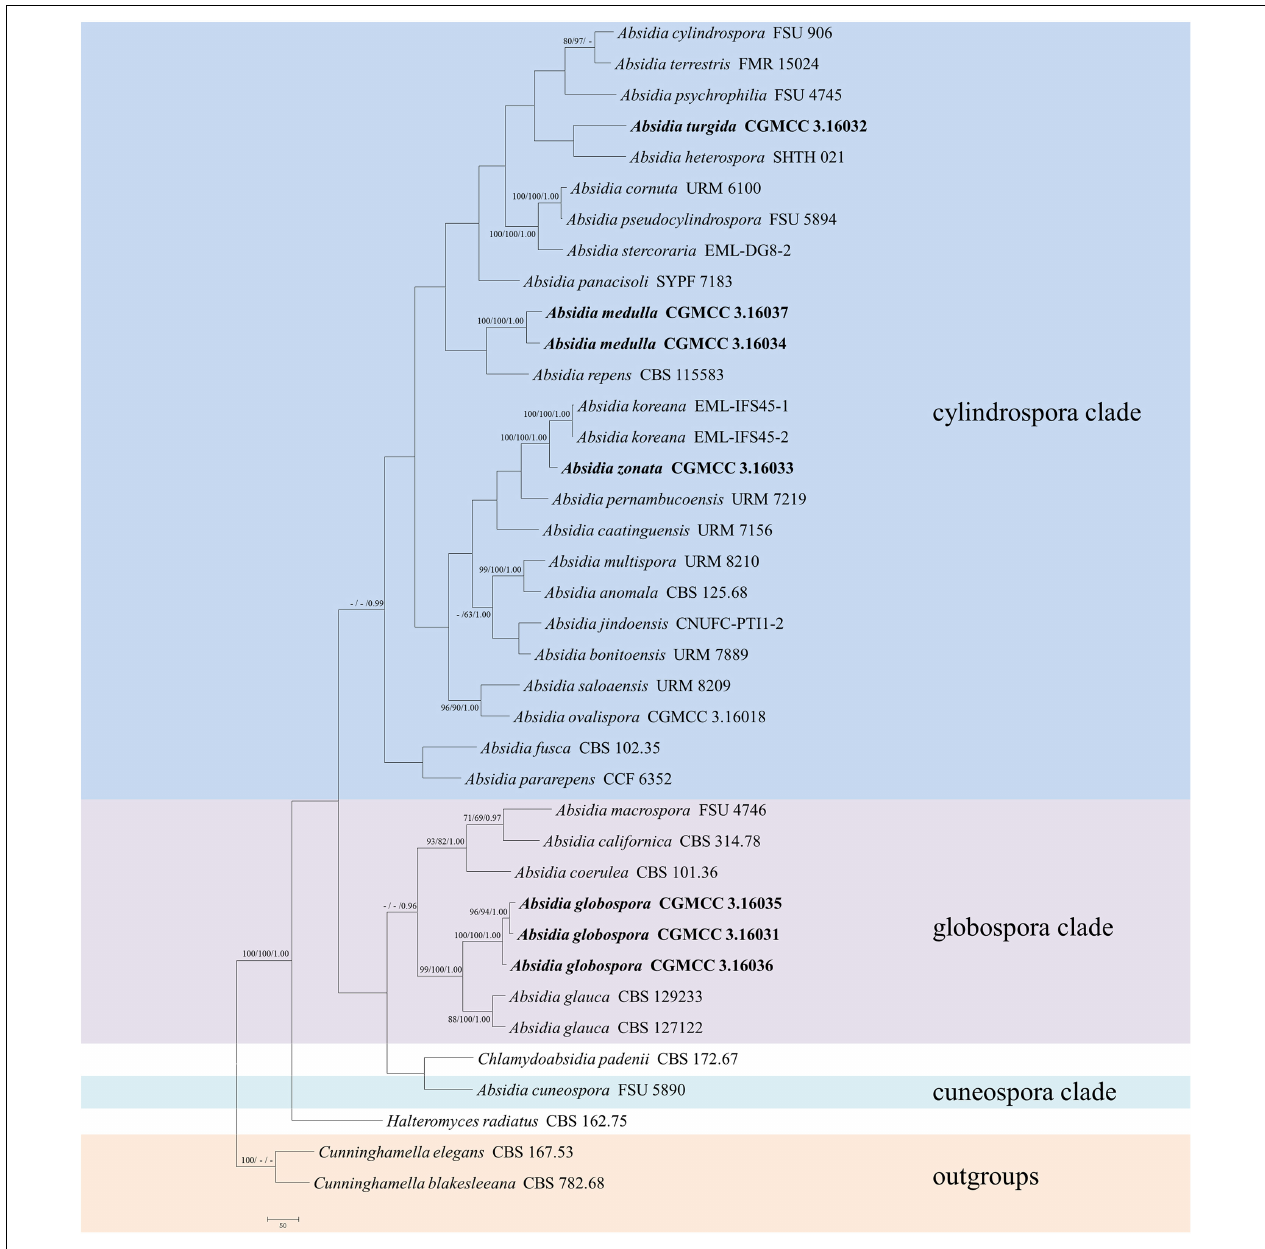
FIGURE 1 | The maximum parsimony strict consensus tree illustrating the phylogeny of four new species of Absidia and related species in Cunninghamellaceae based on ITS sequences. Cunninghamella elegans and Cunninghamella blakesleeana serve as outgroups. Branches are labeled with maximum likelihood bootstrap values higher than 70%, maximum parsimony bootstrap values higher than 50%, and Bayesian posterior probabilities more than 0.95. The lower left scale represents steps.